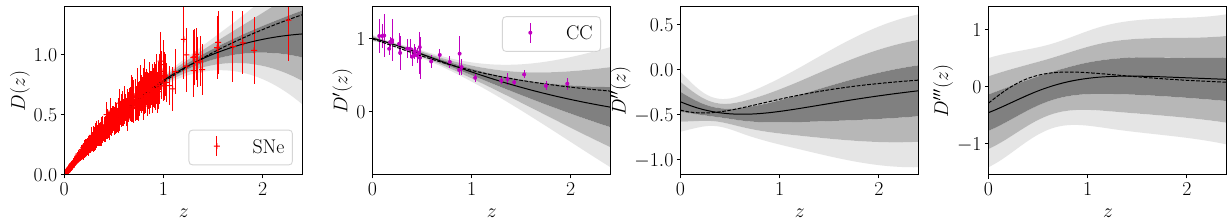
Fig. 4 Plots for the reconstructed dimensionless Hubble parameter h ( z ) , it’s derivatives h (cid:3) ( z ) and h (cid:3)(cid:3) ( z ) using CC + BAO data. The black solid line is the best fit curve and the associated 1 σ , 2 σ and 3 σ confidence regions are shown in lighter shades. The specific points (in the left figure) with error bars represent the observational data. The black dashed line is for the (cid:2) CDM model with (cid:12) m 0 = 0 . 3